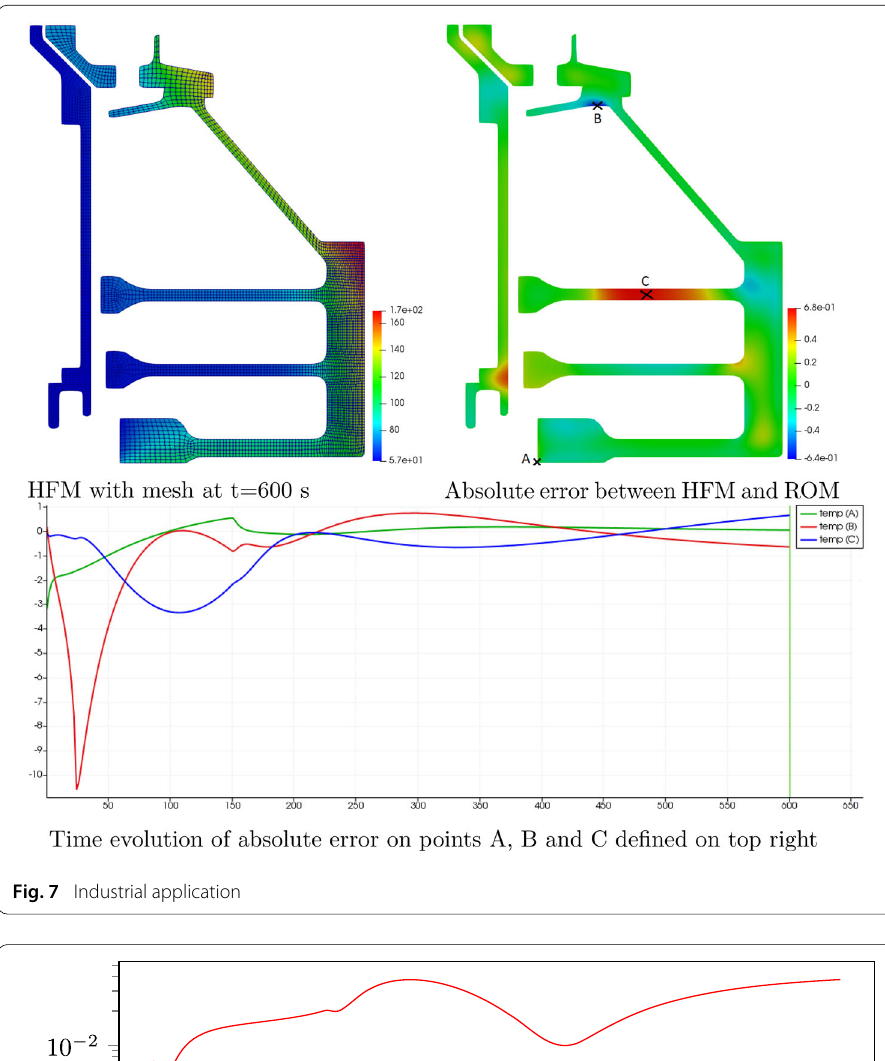
Fig. 7 Industrial application